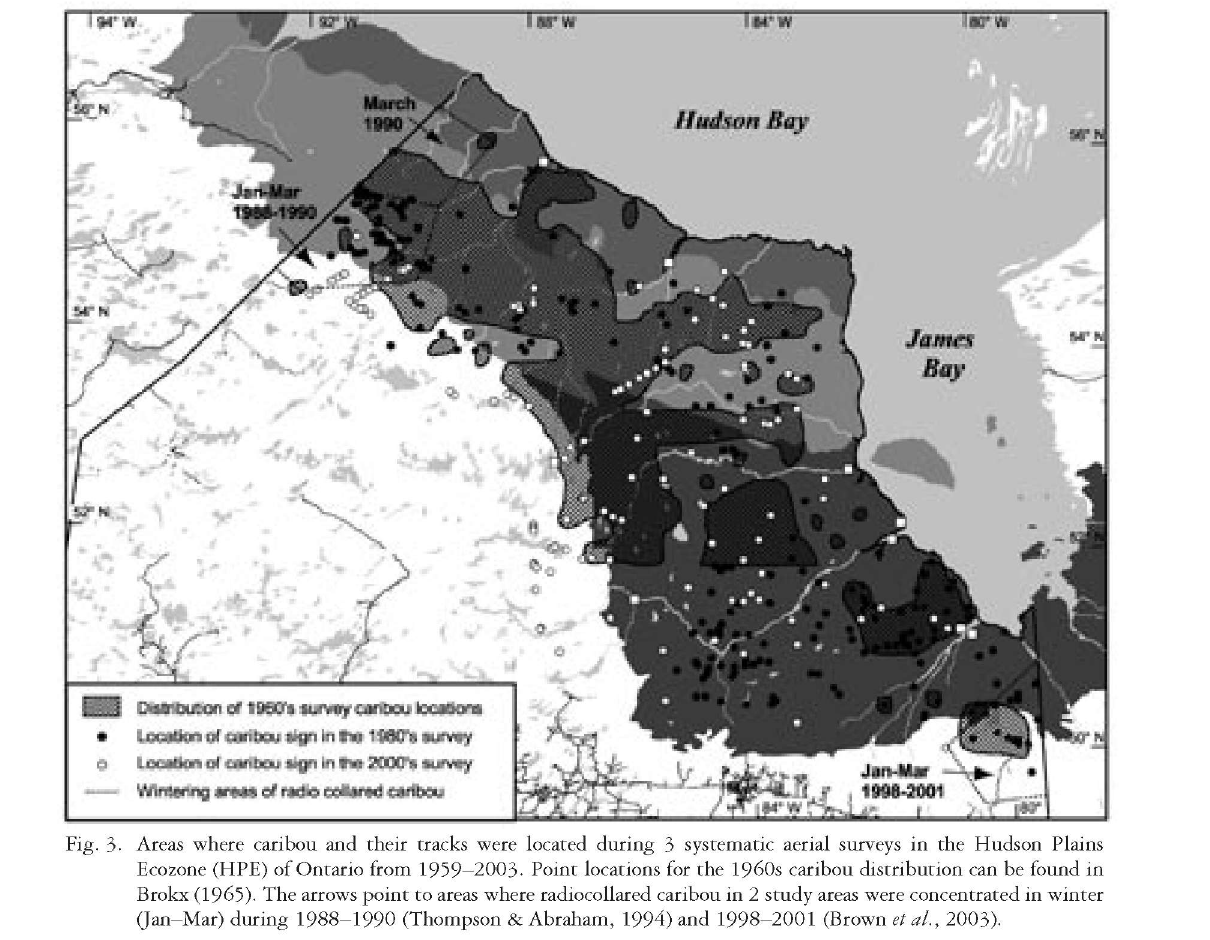
Fig. 3. Areas where caribou and their tracks were located during 3 systematic aerial surveys in the Hudson Plains Ecozone (HPE) of Ontario from 1959—2003. Point locations for the 1960s caribou distribution can be found in Brokx (1965). The arrows point to areas where radiocollared caribou in 2 study areas were concentrated in winter (Jan—Mar) during 1988—1990 (Thompson & Abraham, 1994) and 1998—2001 (Brown et al.,